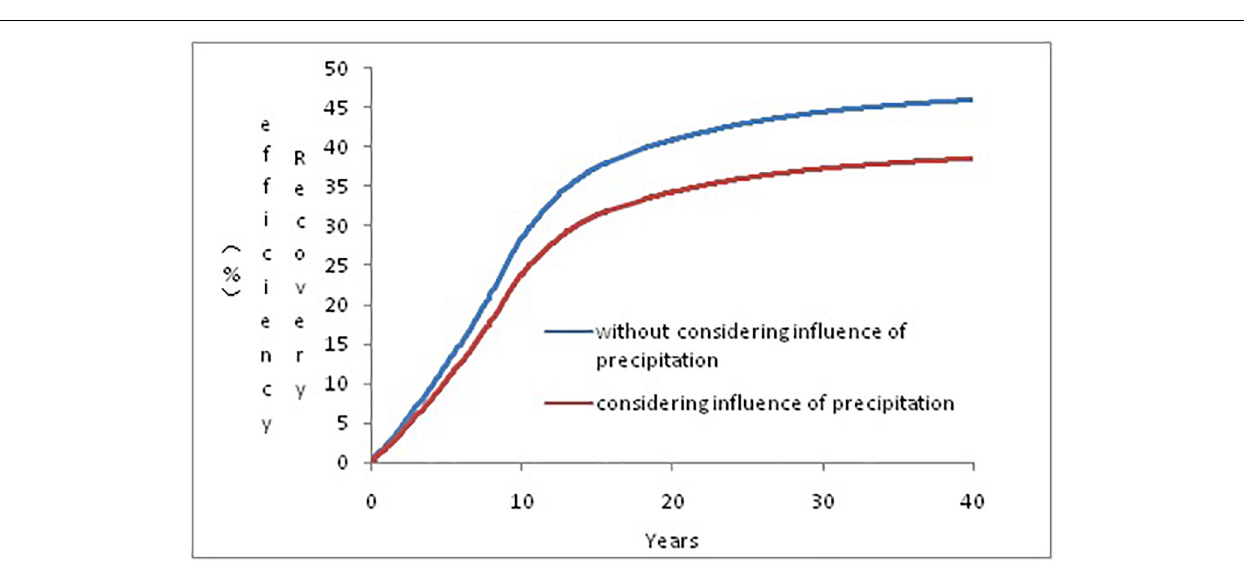
FIGURE 8 | Recovery rate at the 40th year with and without considering the influence of